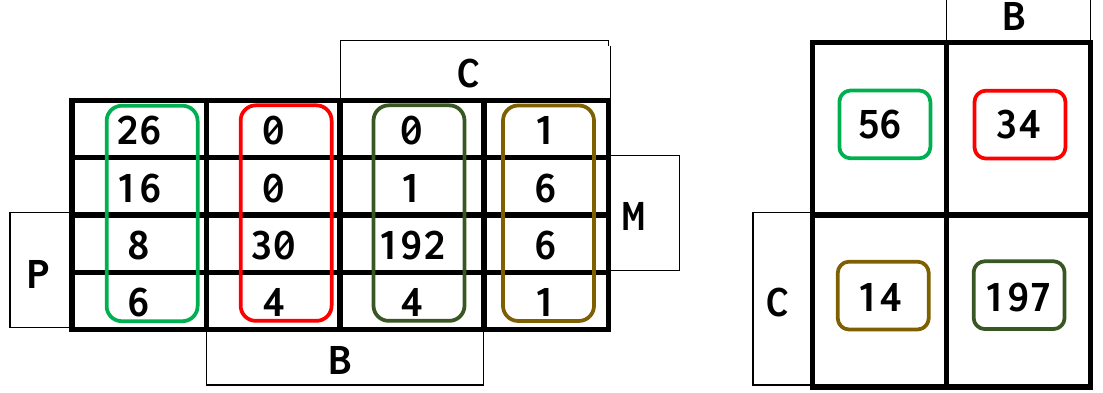
Fig. 3. Map additive elimination of 𝑁 ( 𝐶 , 𝐵 , 𝑃, 𝑀) with respect to 𝑃 and 𝑀 to obtain the contingency table of 𝐶 with respect to 𝐵